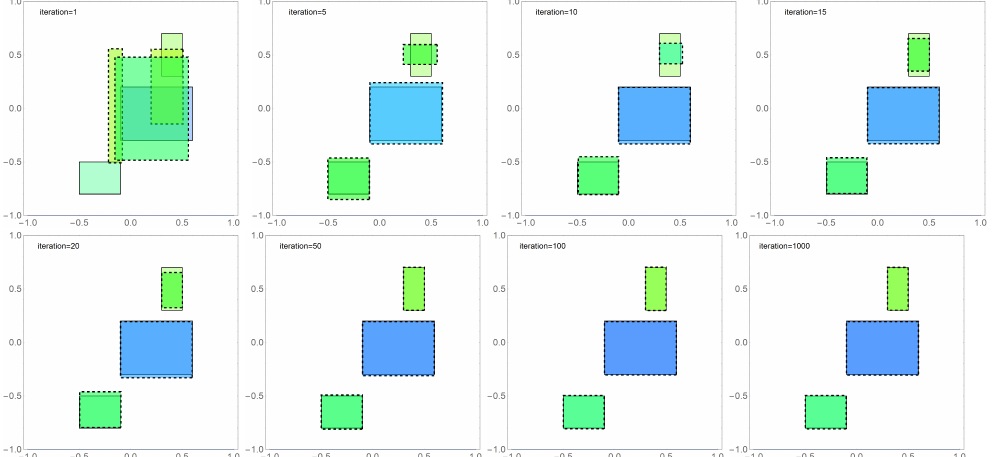
Figure 6. Graphical presentation of the results obtained with the DBOA algorithm for the population n = 800 in selected iterations, where the reconstructed areas are outlined with a dashed line while the exact solution is outlined with solid line, and the area height is marked by